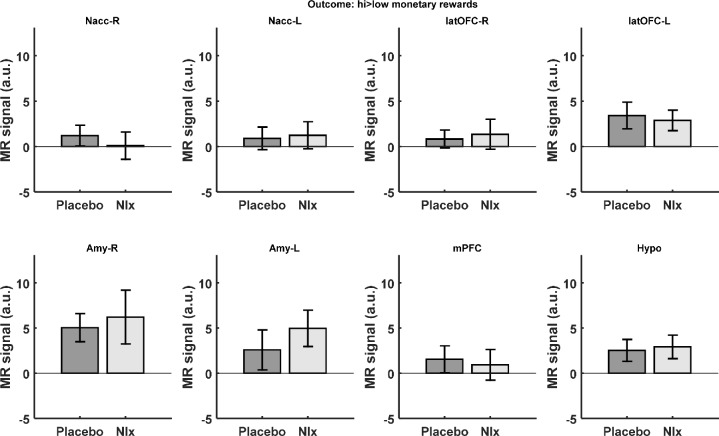
Region of interest contrasts of brain activity for high versus low monetary reward outcome for placebo and naloxone treatment.